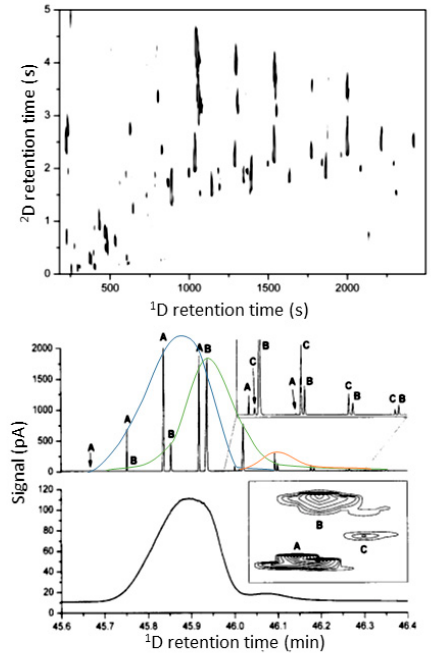
Figure 3. GC × GC-TOFMS volatile profiles of coriander ( top ). Separation of a potent floral, coriander-like odour cluster in coriander leaf ( bottom ). Substances were identified as E -2-dodecanal (A), E -2-dodecen-1-ol (B) and 1-dodecanol (C). Source: adapted with permission from Eyres et al. [50,51].